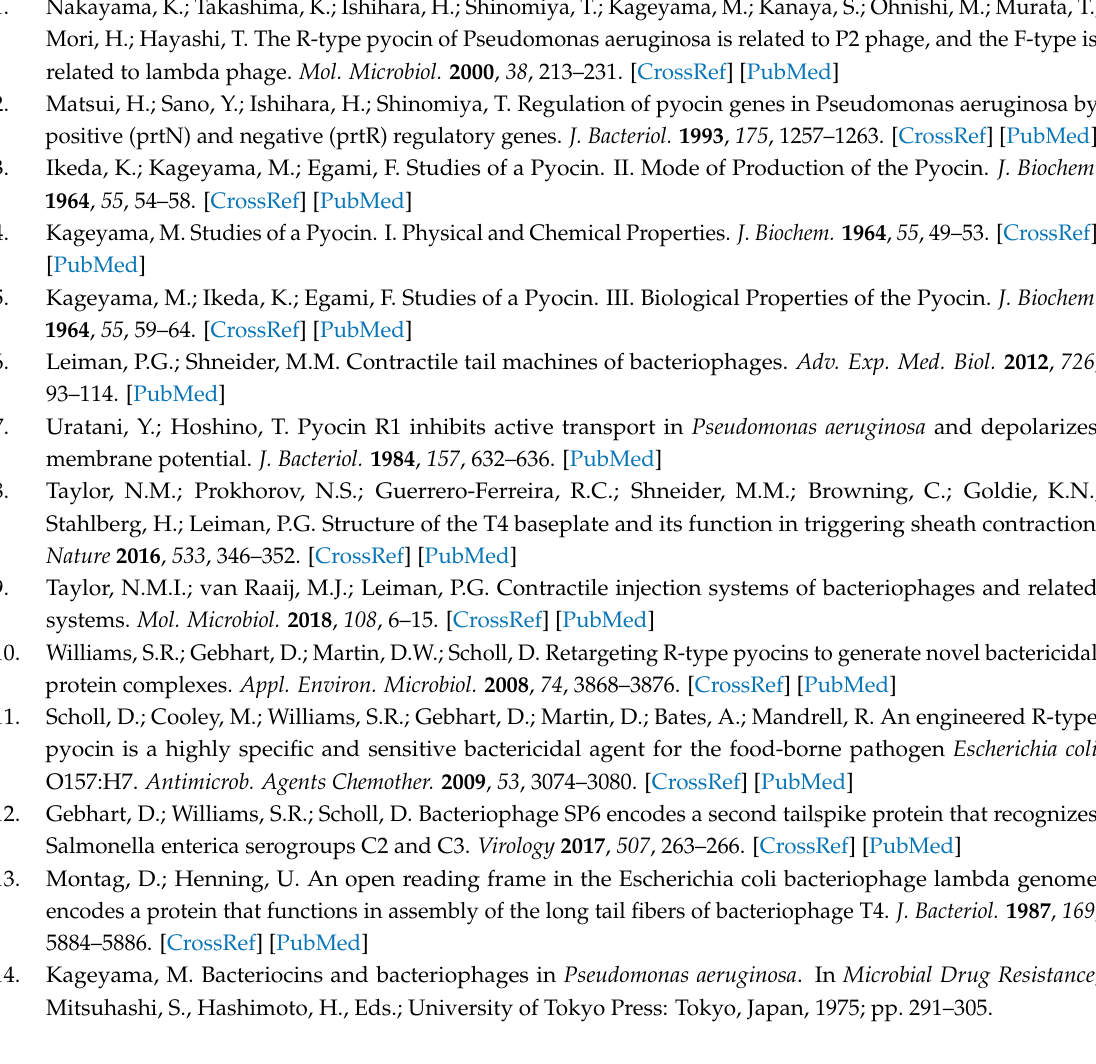
Figure S1. Phylogenetic tree of fiber sequences of the five R-type pyocins. Figure S2. Crystal packing of R1 and R2 pyocin fibers. Figure S3. Location and identification of the ligand buried within the hydrophobic core of the Knob2 domain of R1 pyocin fiber. Figure S4. Location and identification of the ligand buried within the hydrophobic core of the Shaft domain of R2 pyocin fiber. Figure S5. Comparison of the structure of the C-terminal lectin-like domains of R1 and R2 fibers. Table S1. Composition of the R2 pyocin particle as determined by mass-spectrometry. Table S2. Refinement statistics and final electron density map correlation for metal ions contained in the R1 and R2 fibers. Table S3. Identification of buried compounds in the Knob2 domain of the R1 fiber and the Shaft domains of the R2